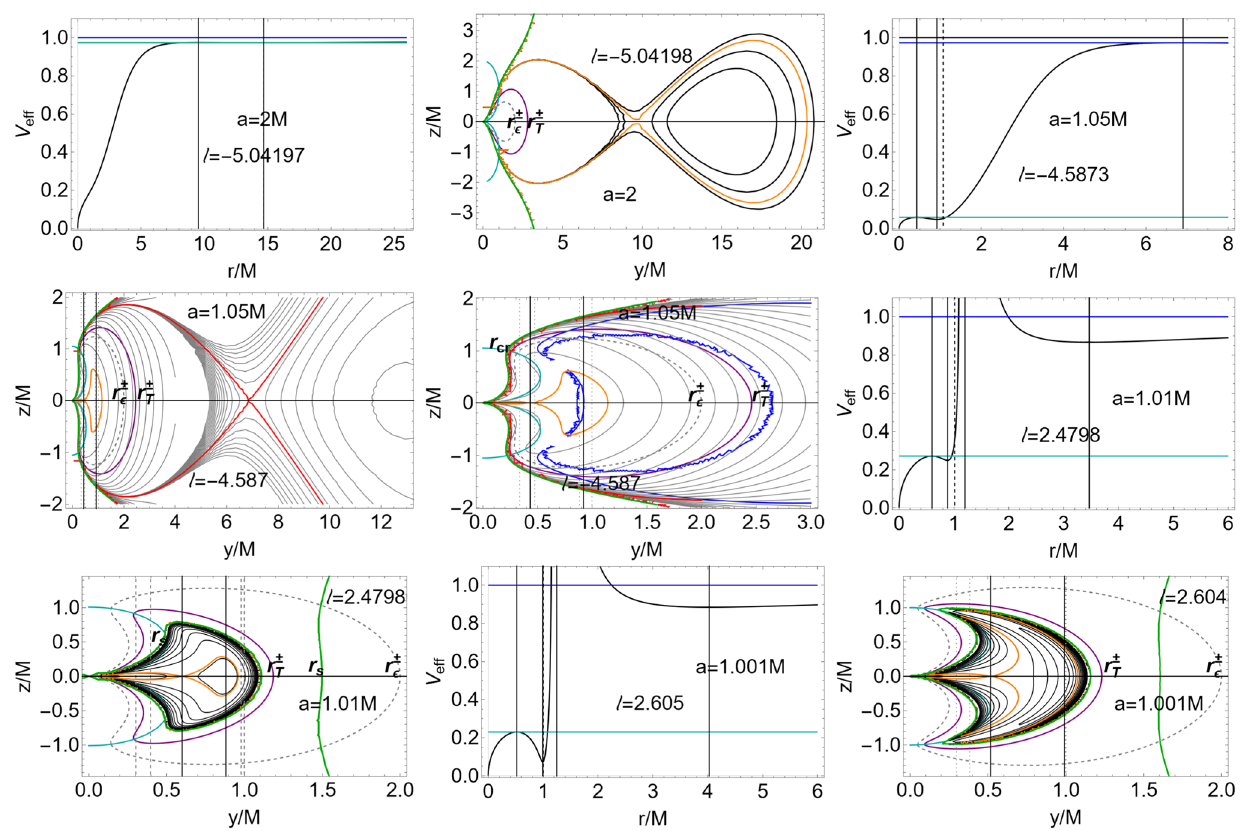
tions r ± (cid:2) and σ (cid:2) are shown, while discussion on the constrains is in Sect. 3.2.) Note the inversion radius location with respect to the ergo- surface r ± (cid:11) . For (cid:6) − > 0 inversion points are only for space-like particles with ( E < 0 , L < 0 ) in the conditions of Sec. (C). The limiting bound- ary configuration for the inner torus is the defined by the light surface (cid:6) r s with frequency ω = 1 /(cid:6) (darker-green surface) – See also Figs. 13 z 2 + y 2 and